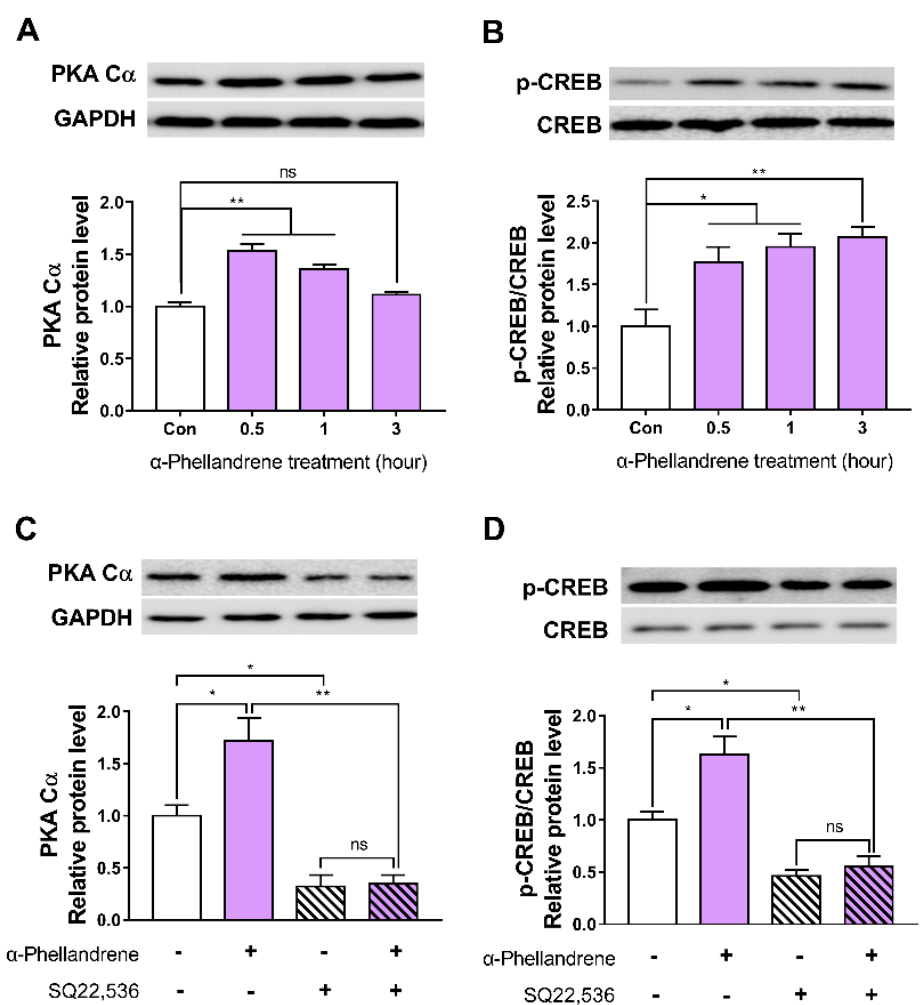
Figure 3. α -phellandrene-mediated cyclic adenosine monophosphate (cAMP) accumulation stimulates the downstream protein kinase (PKA)/cAMP-responsive element-binding protein (CREB) signaling in dermal papilla cells (DPCs). DPCs were treated with vehicle (dimethyl sulfoxide; DMSO) or 12.5 µ M α -phellandrene for 0.5, 1, and 3 h, following which ( A ) protein kinase A catalytic subunit (PKA C α ) expression and ( B ) CREB phosphorylation were quantified by western blotting. Cells were incubated with either vehicle or 12.5 µ M of α -phellandrene for 0.5 h. The cells were preincubated with the vehicle or 50 µ M of SQ22,536 (cAMP inhibitor) for 1 h before α -phellandrene treatment. ( C ) PKA C α expression and ( D ) CREB phosphorylation were quantified by western blotting. Relative PKA C α protein expression was normalized to glyceraldehyde 3-phosphate dehydrogenase (GAPDH) level and the ratio of CREB phosphorylation normalized to total CREB is shown ( p -CREB/CREB). Results are expressed as mean ± standard error of the mean (SEM) of three independent experiments. Statistically significant differences are marked as ns, not significant ( p > 0.05); * p < 0.05; ** p < 0.01.